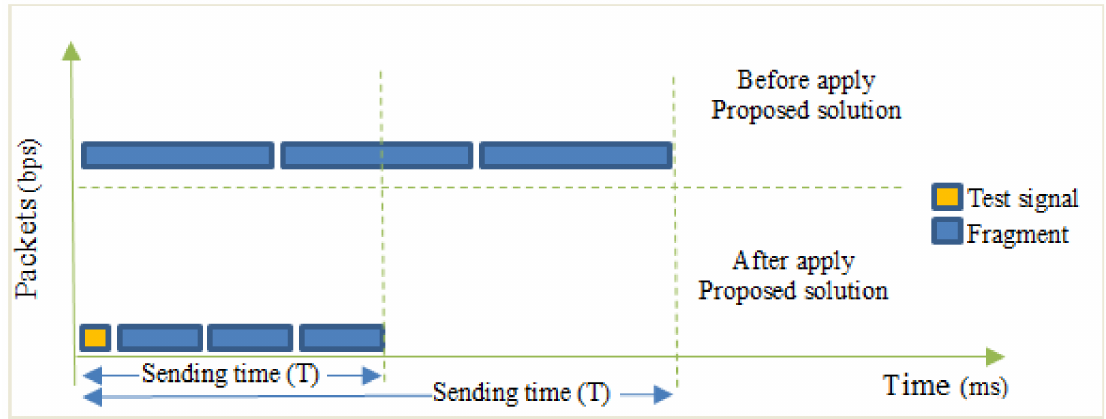
Figure 12. Proposed system timing